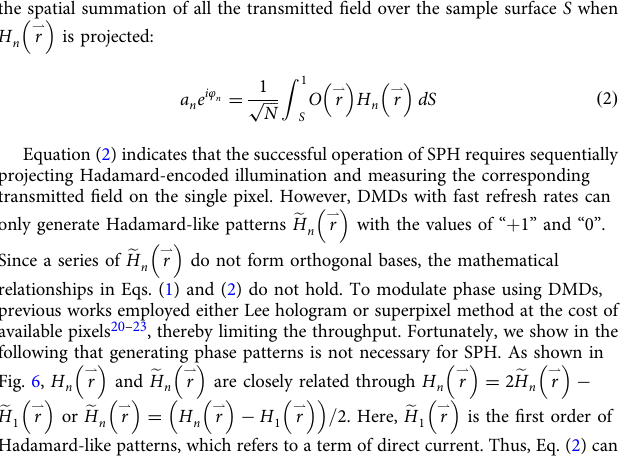
relationships in Eqs. (1) and (2) do not hold. To modulate phase using DMDs, previous works employed either Lee hologram or superpixel method at the cost of available pixels 20 – 23 , thereby limiting the throughput. Fortunately, we show in the following that generating phase patterns is not necessary for SPH. As shown in (cid:1) (cid:3) (cid:1) (cid:3) (cid:1) (cid:3) (cid:1) (cid:3) * * * * ¼ 2 e H (cid:3) Fig. 6, H n r and e H n r are closely related through H n r n r (cid:1) (cid:3) (cid:1) (cid:3) (cid:1) (cid:3) (cid:1) (cid:3)(cid:1) (cid:3) (cid:1) (cid:3) * * * * * e H ¼ H (cid:3) H = 2. Here, e H or e H n r is the fi rst order of 1 r n r 1 r 1 r Hadamard-like patterns, which refers to a term of direct current. Thus, Eq. (2) can